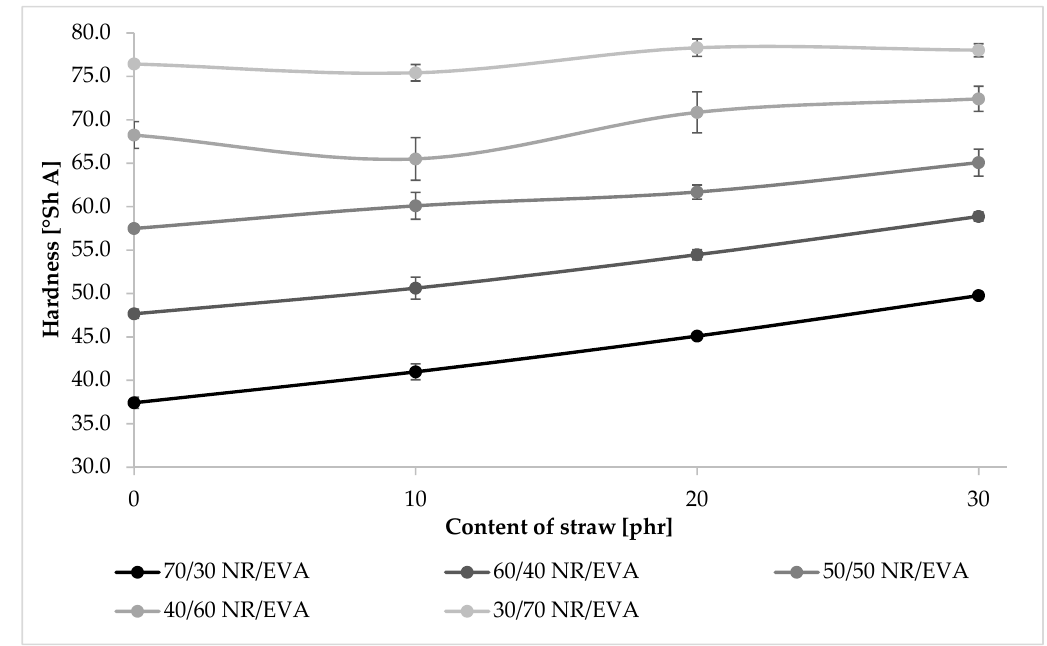
Figure 4. The hardness values of biocomposites. Materials 2020 , 13 , x FOR PEER REVIEW